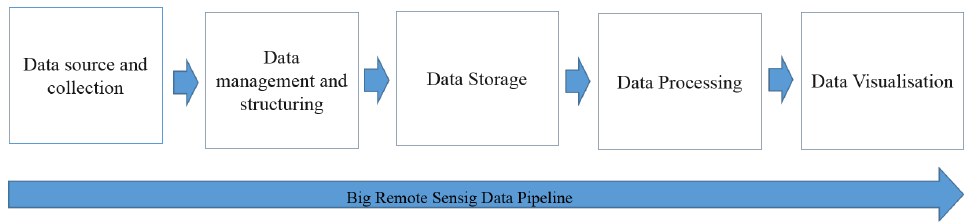
Figure 1. Generic big data